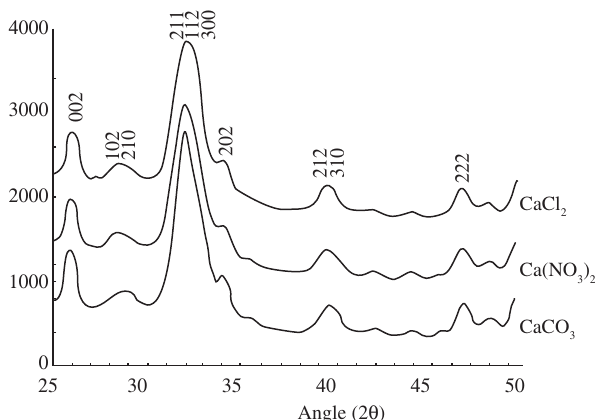
Figure 1. XRD patterns of obtained powders.